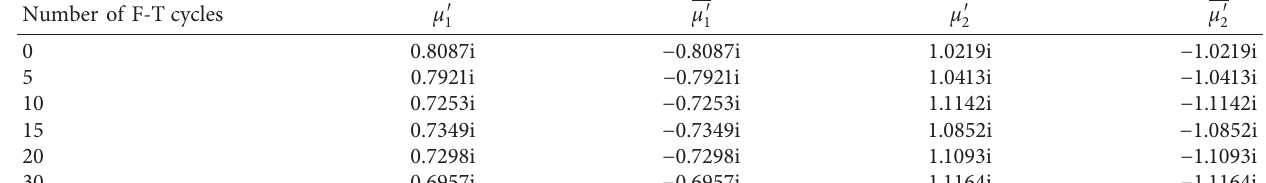
Table 3: Complex roots of the compatible equation with different numbers of F-T